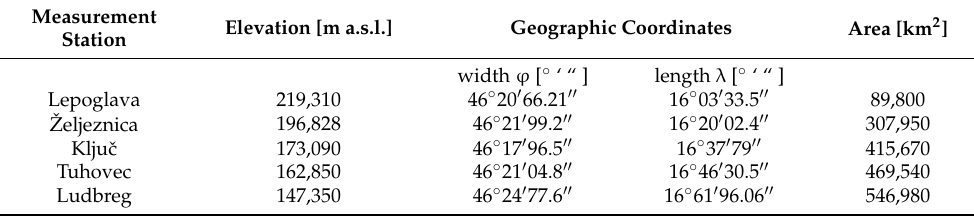
Table 1. Elevation, geographic coordinates, and area of the measurement stations on Bednja River [20]. Measurement